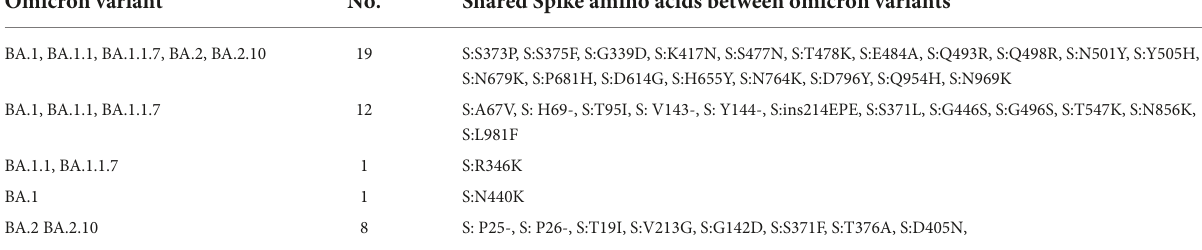
TABLE 3 Shared amino acid substitutions in the spike protein of BA.1, BA.1.1, BA.1.1.7, BA.2, and BA.2.10 lineages. Omicron variant No. Shared Spike amino acids between omicron